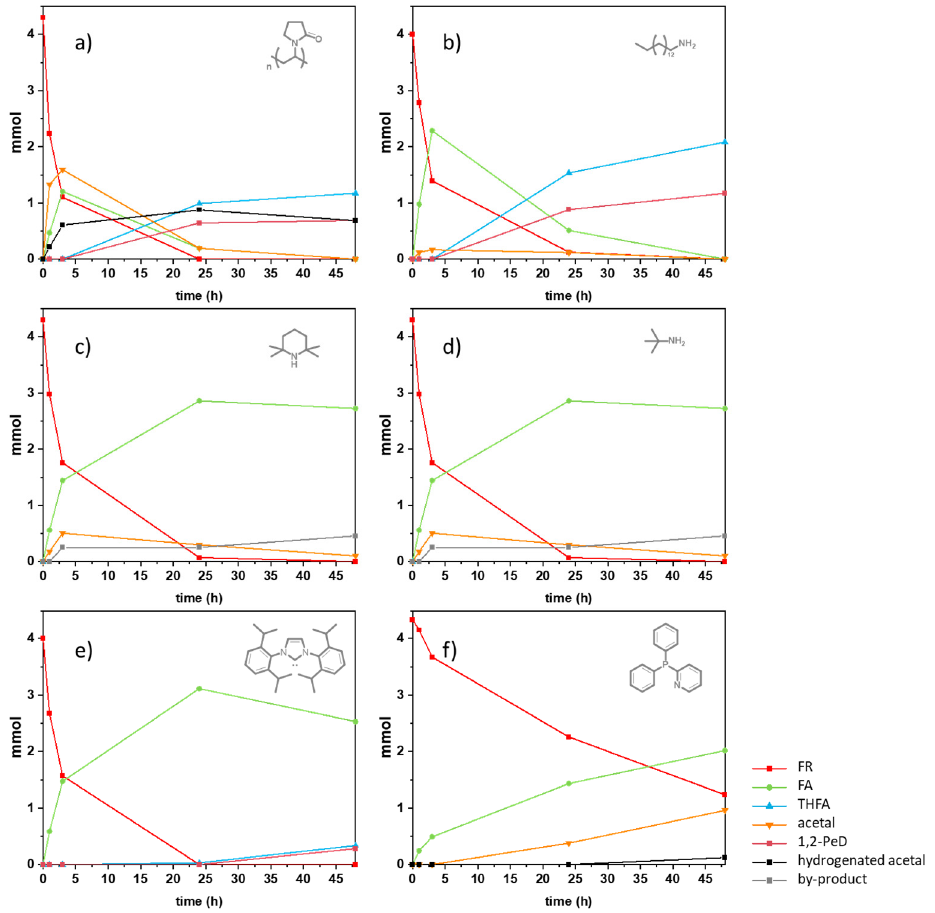
Figure 2. Time–concentration curves for furfural hydrogenation using in situ modified Ru/PVP as catalyst together with unmodified Ru/PVP. ( a ) Ru/PVP; ( b ) Ru/PVP modified with HDA; ( c ) Ru/PVP modified with TMP; ( d ) Ru/PVP modified with TBA; ( e ) Ru/PVP modified with NHC; and ( f ) Ru/PVP modified with PN. Furfural (red curve), furfuryl alcohol (green curve), tetrahydrofurfuryl alcohol (blue curve), acetal (orange curve), 1,2 ‐ pentanediol (pink curve), hydrogenated acetal (black curve), unidentified products (grey curve). Reaction conditions: 2 × 10 − 2 mmol of Ru, 4 mmol of FR, 0.5 mmol of dodecane (internal standard), ( b ) 6 × 10 − 2 mmol of HDA, ( c ) 6 × 10 − 2 mmol of TMP ( d ) 6 × 10 − 2 mmol of TBA, ( e ) 2 × 10 − 2 mmol of NHC, ( f ) 3 × 10 − 2 mmol of PN, 20 bar of H 2 , 125 °C, 15 mL of